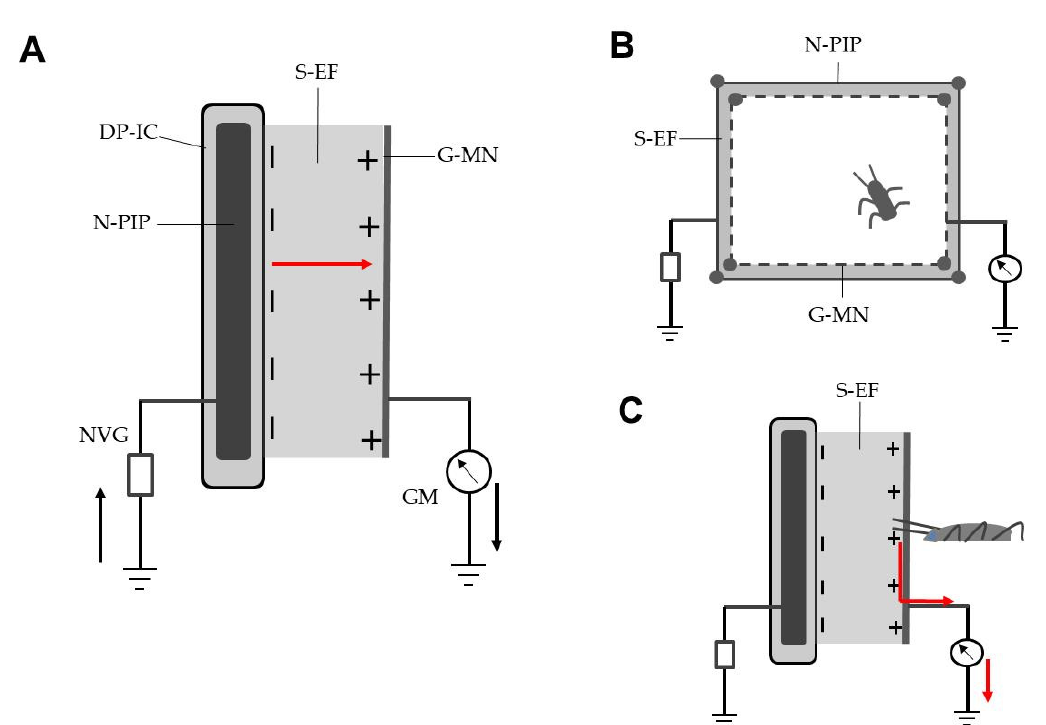
Figure 1. ( A ) Schematic representation of the static electric field producer (S-EFP) (cross-sectional view). The solid arrow denotes electron movement from electrode to ground via mechanical discharge (red arrow) between opposite poles. ( B ) A square surrounded by four S-EFPs was used to examine the insect avoidance behaviour (bird’s-eye view). ( C ) Flow of a transient electric current (red arrow) from an insect that inserted its antennae into the static electric field. Abbreviations: DP-IC, dielectrically polarised insulator coating with negative charge on outer surface; N-PIP, negatively charged polyvinyl chloride-insulated iron plate; NVG, negative voltage generator; S-EF, static electric field; G-MN, grounded metal (stainless steel) net; GM, galvanometer.